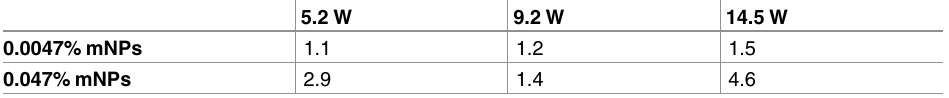
Table 2. The ratio of the initial slope of the temperature trace, normalized by the slope for the case of 0% mNPs at each